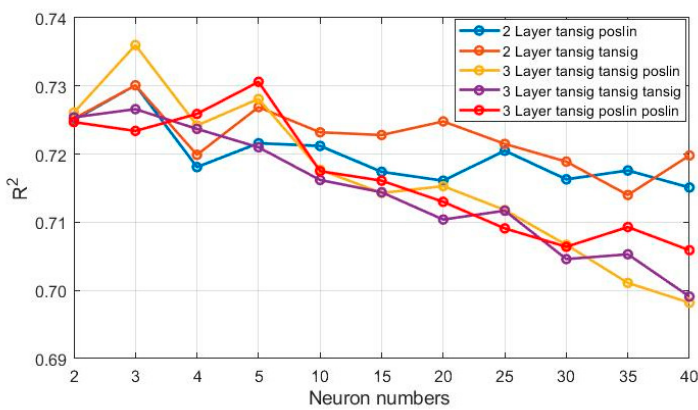
Figure 1. Artificial neural network (ANN) performance measured in R 2 of projecting OHC300 as a function of neuron numbers ( x -axis). Different colors denote different combinations of hidden-layer numbers and activation functions. The training data is from 2005 to 2013 with a feature combination of Case 4 (see Table 1). The test data here is 12 months of 2017. In the legend, “tansig” means the tangential sigmoid activation function, while “poslin” means the Rectified Linear Unit (ReLU).